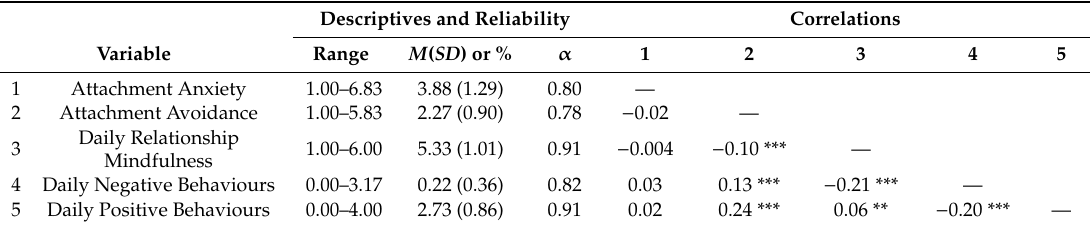
Table 1. Descriptive statistics, reliability information, and correlations among study